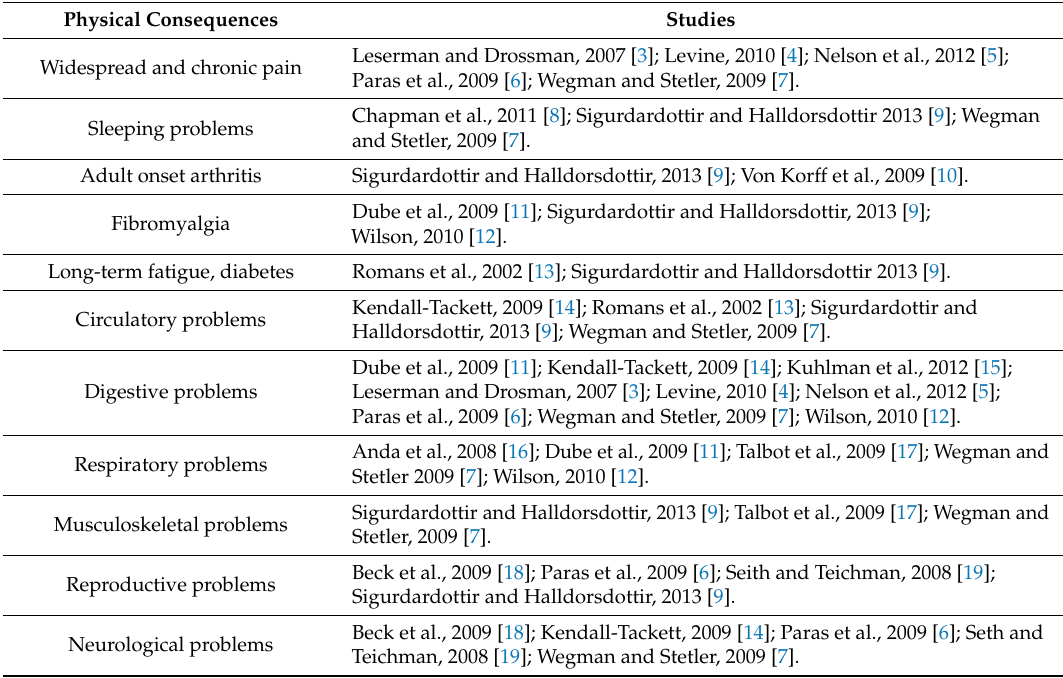
Table 1. Known physical consequences of CSA.